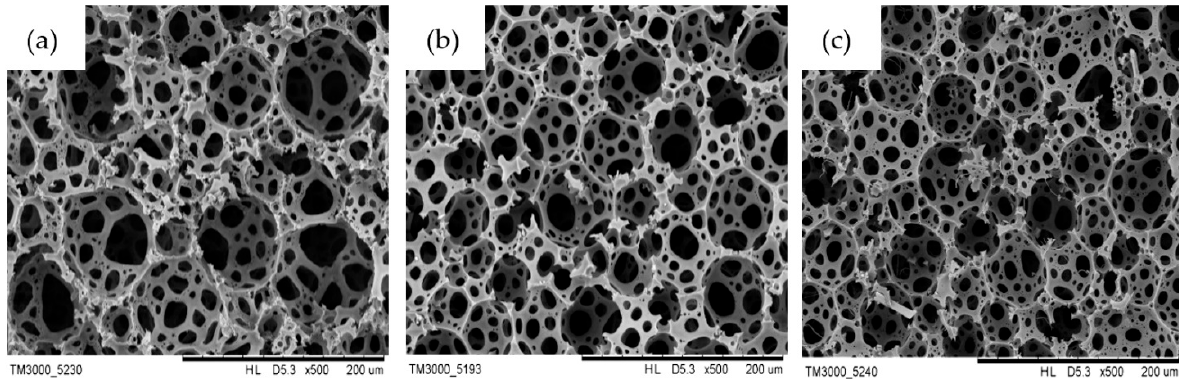
Figure 2. Scanning electron micrographs of different ratio S/DVB of poly(S/DVB)HIPE: ( a ) 80:20, ( b ) 20:80, and ( c ) 0:100.